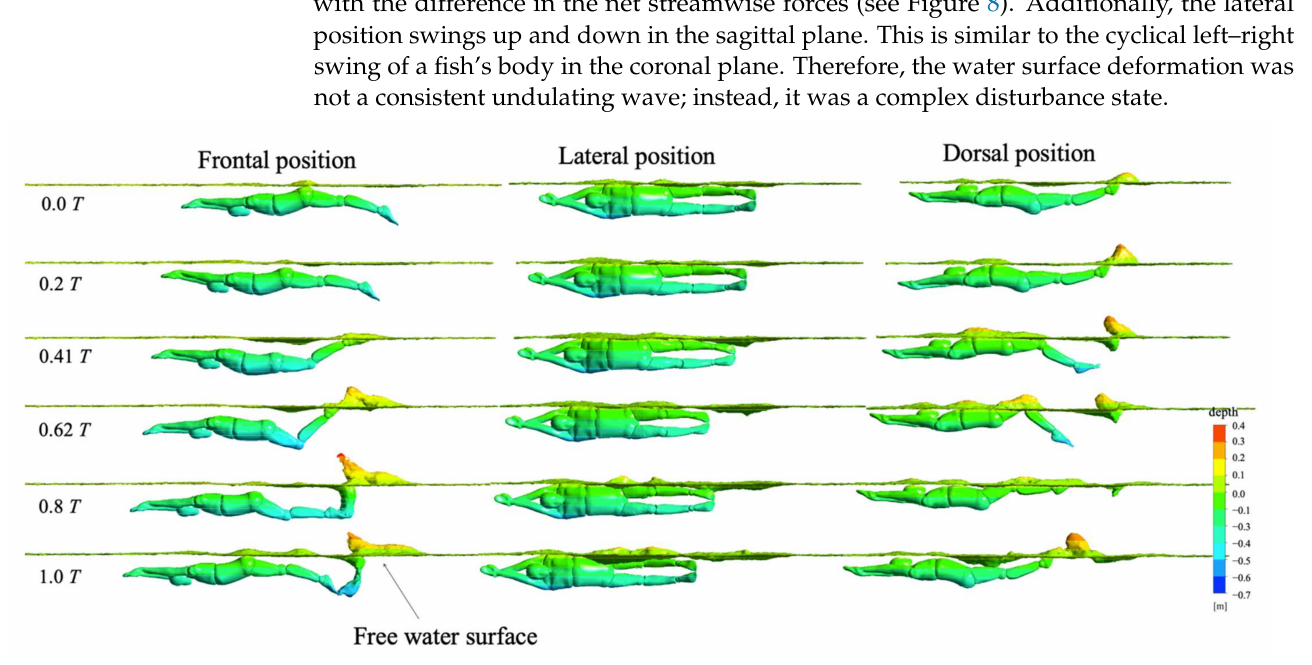
Figure 12. Wave evolution diagram near the water